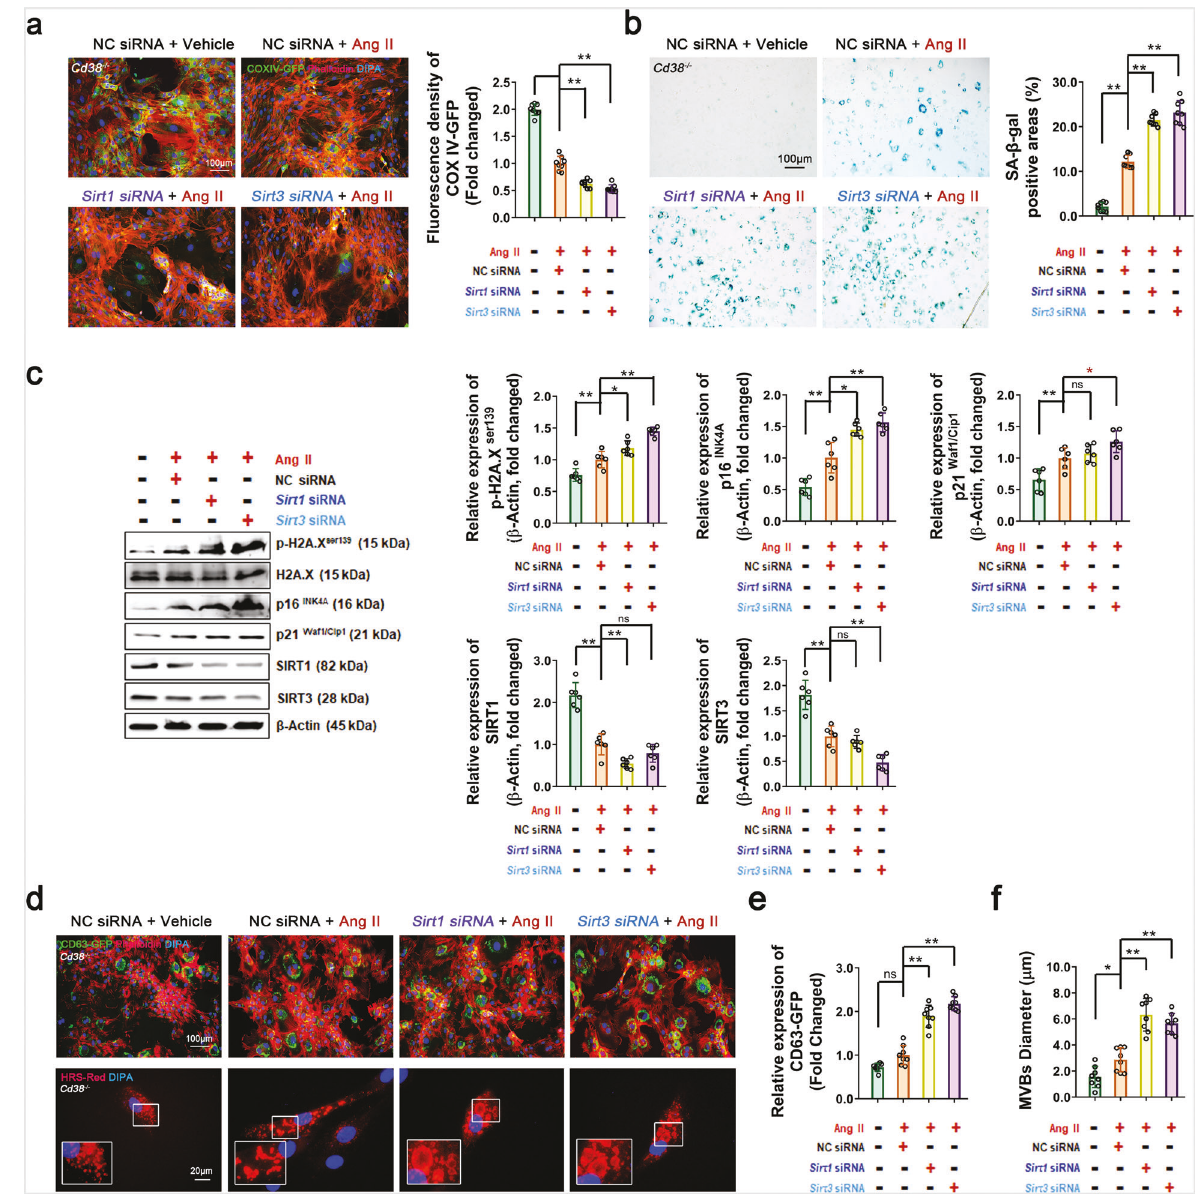
Fig. 6 CD38 de fi ciency-mediated SIRT1/SIRT3 activation alleviated VSMC senescence by inhibiting the biogenesis and secretion of SA-sEVs. a In vitro mitochondria quantity analysis. The mitochondrial mass was analyzed in stable Cd38 − / − COX IV-GFP VSMCs. VSMCs were transfected with Sirt1 and Sirt3 siRNAs and negative control (NC) siRNA. After transfection overnight, Ang II (100 nM) was added and maintained for 3 days. The mitochondria were tracked using green fl uorescent dots ( n ≥ 5, one-way ANOVA, * p < 0.05, ** p < 0.01). b , c In vitro VSMC senescence analysis. VSMC senescence was analyzed by SA- β -gal staining ( b ) and western blot analysis of aging-related proteins ( c ) ( n ≥ 5, one-way ANOVA, * p < 0.05, ** p < 0.01). The Cd38 − / − VSMCs were transfected with siRNA. After transfection overnight, Ang II (100 nM) was added and maintained for 3 days. Then, the total proteins were extracted for analysis. d – f In vitro sEV biogenesis analysis. CD63-GFP + exosomes and HRS-RFP + MVBs were analyzed in stable Cd38 − / − CD63-GFP VSMCs and Cd38 − / − VSMCs. VSMCs were transfected with siRNA or siRNA